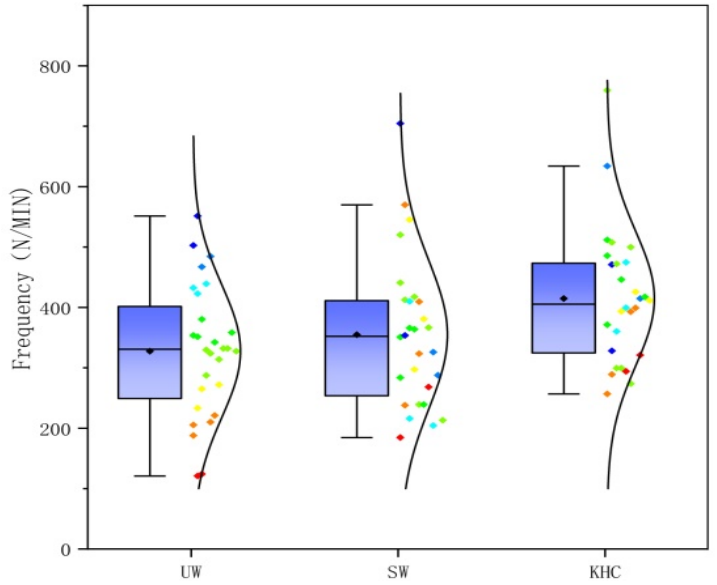
Figure 9. The frequency of joints in three postures. UW—upright walking; SW—stoop walking; KHC—knee and hand crawling. Table 3. Relationship among postures with motion-capture measures.